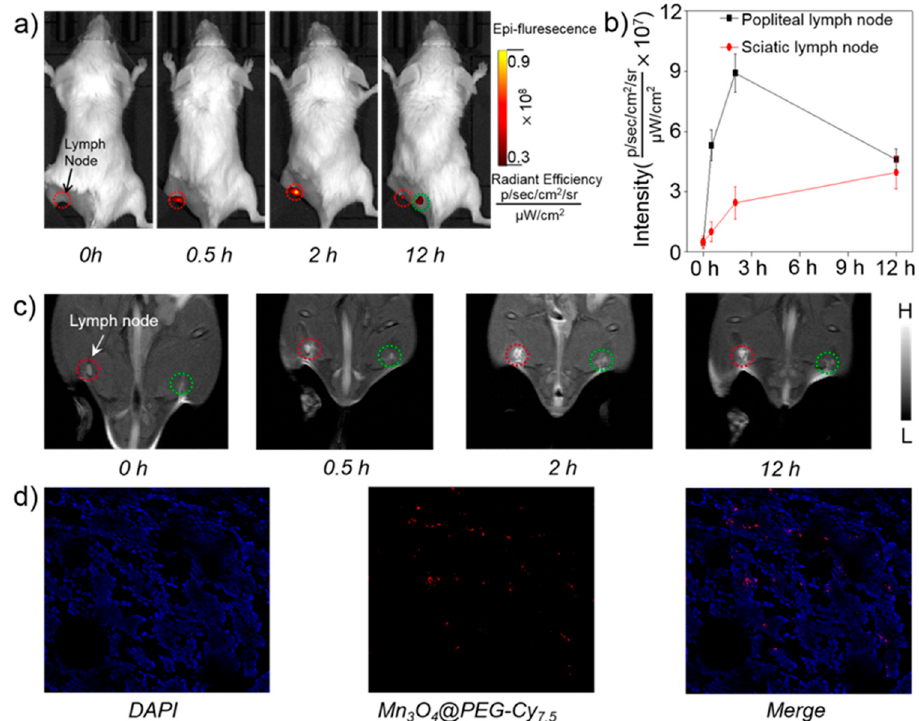
Figure 6. In vivo FI/MR imaging of lymph nodes with Mn 3 O 4 @PEG-Cy 7.5 NPs. ( a ) In vivo FI imaging acquired after subcutaneous injection of Mn 3 O 4 @PEG-Cy 7.5 NPs into the left footpad of the mouse ( n = 3). Lymph nodes are indicated by circles; ( b ) Quantification of the Mn 3 O 4 @PEG-Cy 7.5 NPs uptake by the lymph node ( n = 3); ( c ) In vivo MR imaging of the lymph nodes before and after injection of Mn 3 O 4 @PEG-Cy 7.5 NPs into the left footpad of the mouse ( n = 3). Lymph nodes are indicated by circles; ( d ) Laser confocal images of the lymph node in mouse injected with Mn 3 O 4 @PEG-Cy 7.5 NPs.